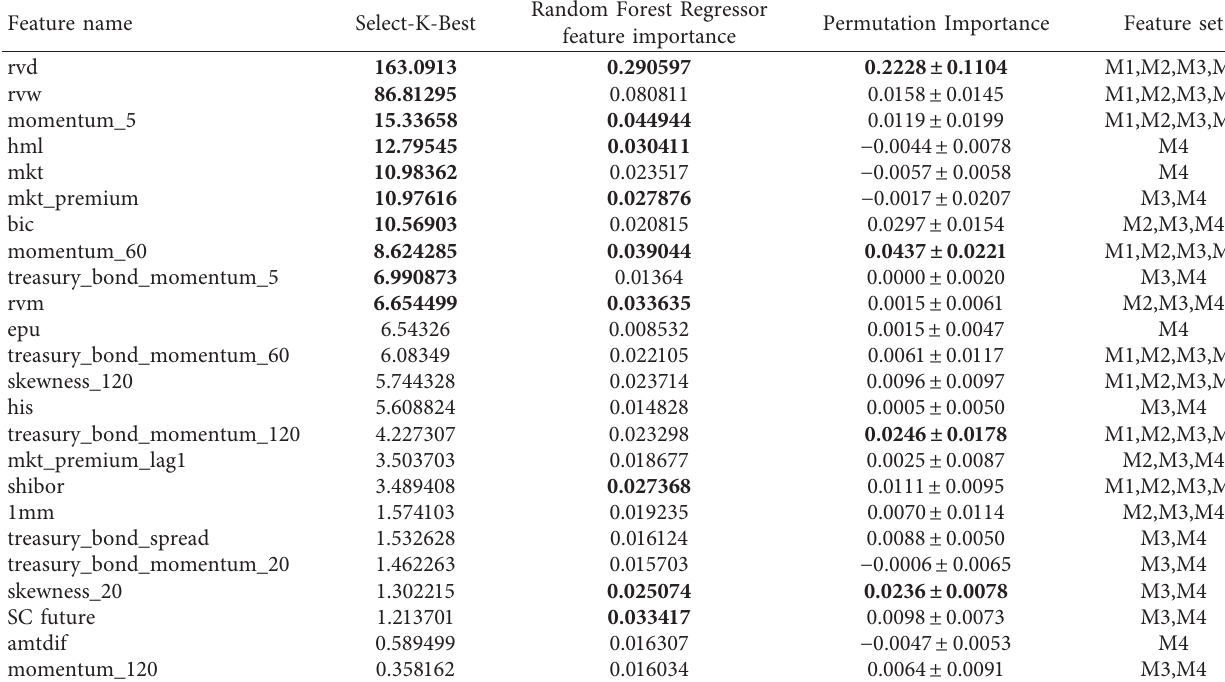
Table 2: Scoring and ranking of feature importance by 3 different feature selection algorithms.